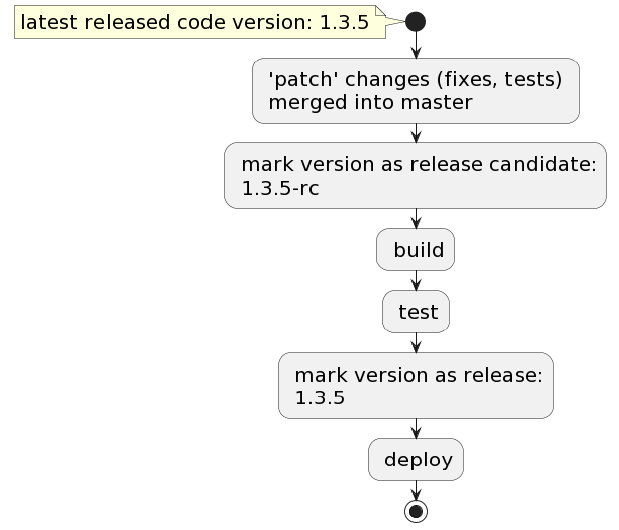
Figure 1. UML Diagram of the proposed solution.